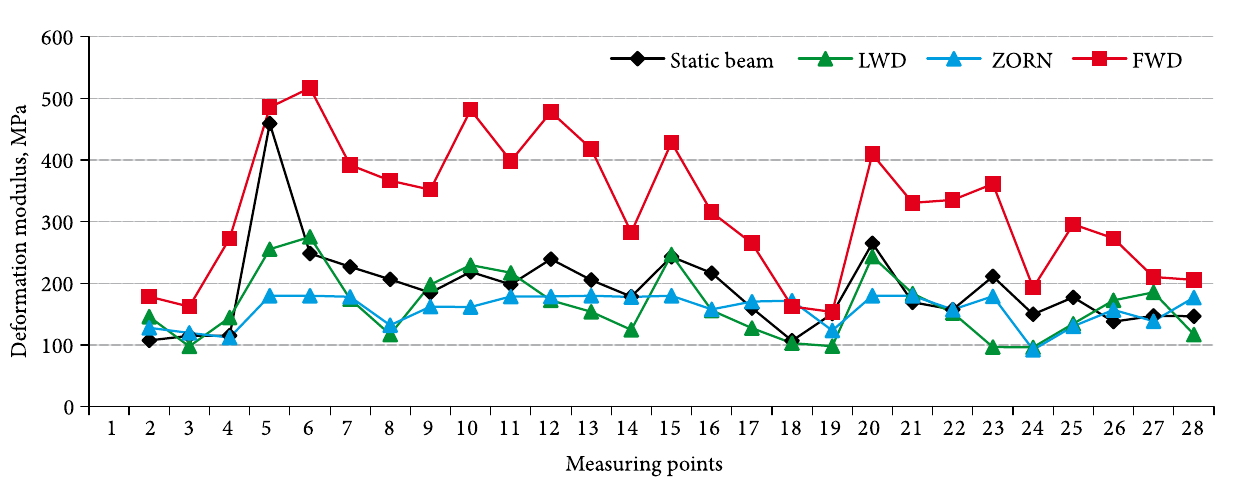
fig. 6. Measuring results of the subgrade (left side)